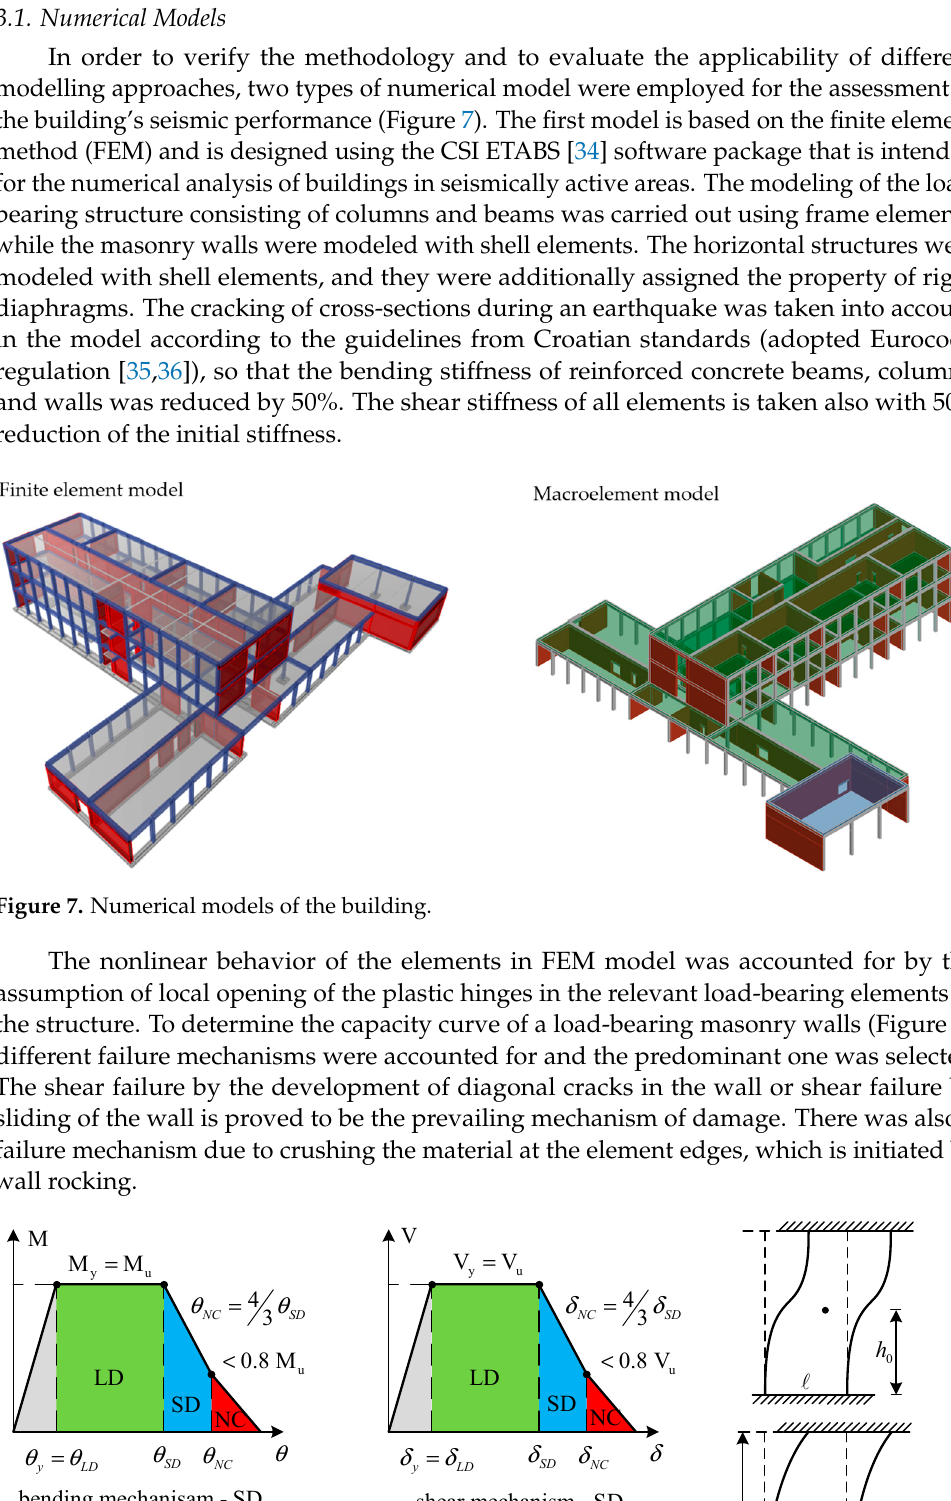
Figure 8. Typical force–deformation relation for masonry elements.